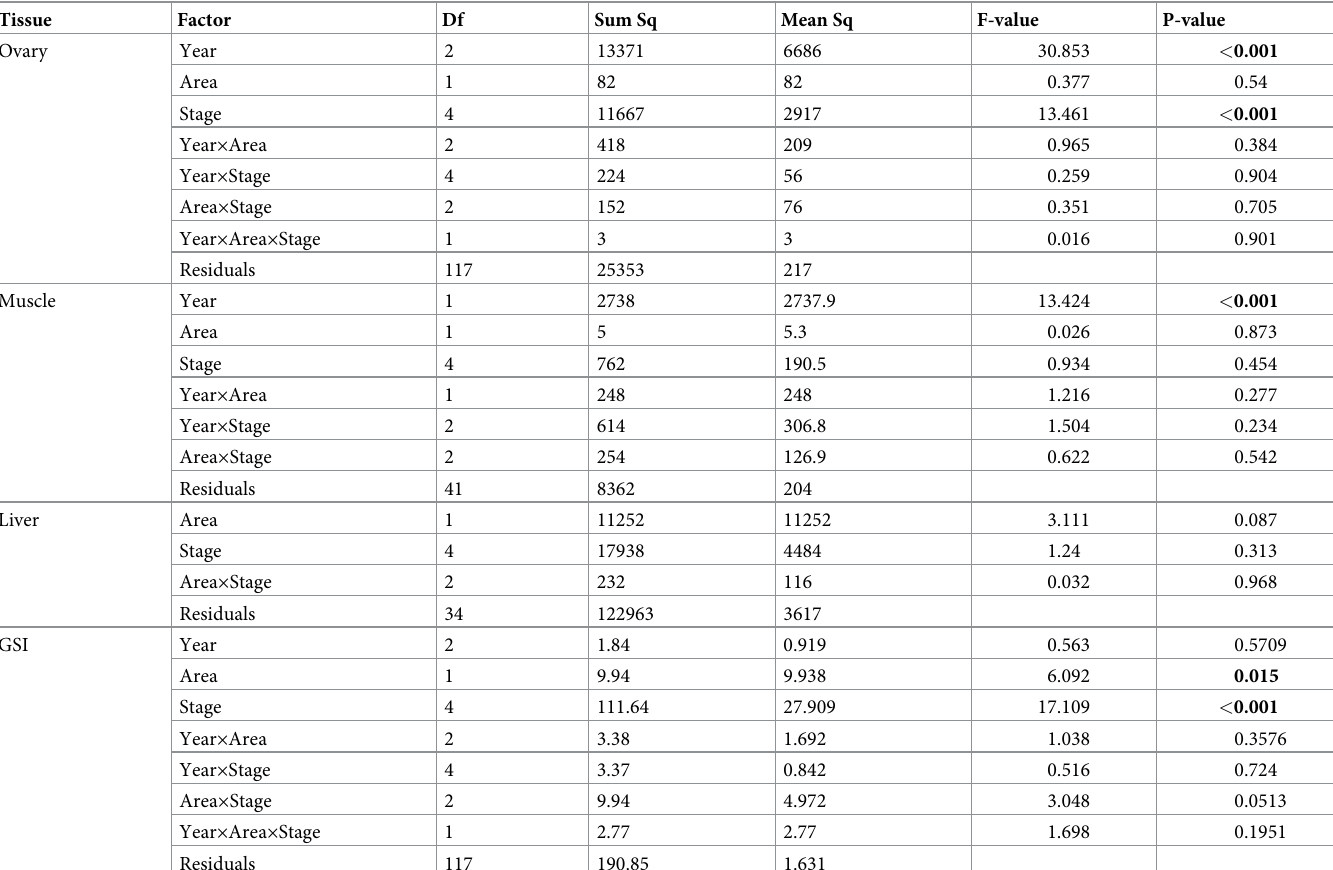
Table 2. Anova results (two- and three-way) for tissue-type TL and GSI.